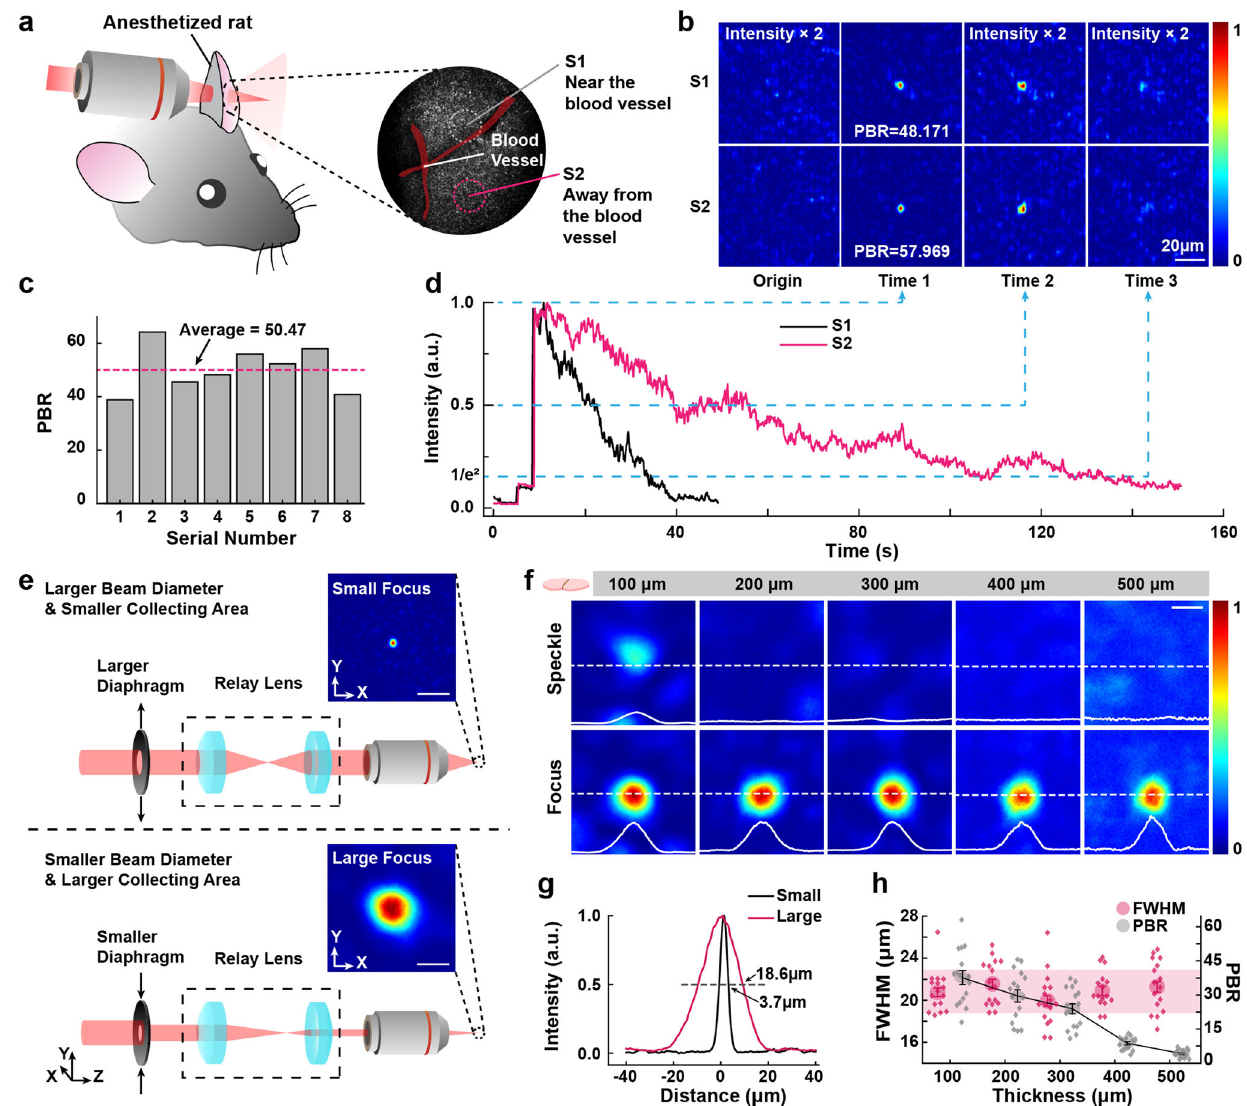
Fig. 3 The focusing ability under different applications. a Handling of the experimental mouse and the schematic of the focusing position. b The focus PBR right after the focusing procedure fi nished at several positions on the mouse ear. c Images of the conventional and fCOAT generated focus pro fi le through living mouse ear at two different positions shown in a at different time points. Scale bar, 20 μ m. d The intensity pro fi les of the peak position of the focus shown in c as a function of time. e Schematics of the generation of small (top) and large (bottom) focus. Scale bar, 20 μ m. f Images of the conventional and fCOAT generated focus pro fi le through brain tissue slices (100, 200, 300, 400, and 500 μ m thick). The intensity pro fi le of the dotted section line in the fi gures are shown at the bottom edge of the images. Scale bar, 20 μ m. g A comparison of the intensity pro fi les between small and large focus through 200 μ m brain slices. h The statistical data of the FWHM focal spot sizes and the PBR of the focus as the functions of tissue thickness. The shadow represents the centralized area of FWHM data points. Error bars represent the SE of sixteen measurements taken at different